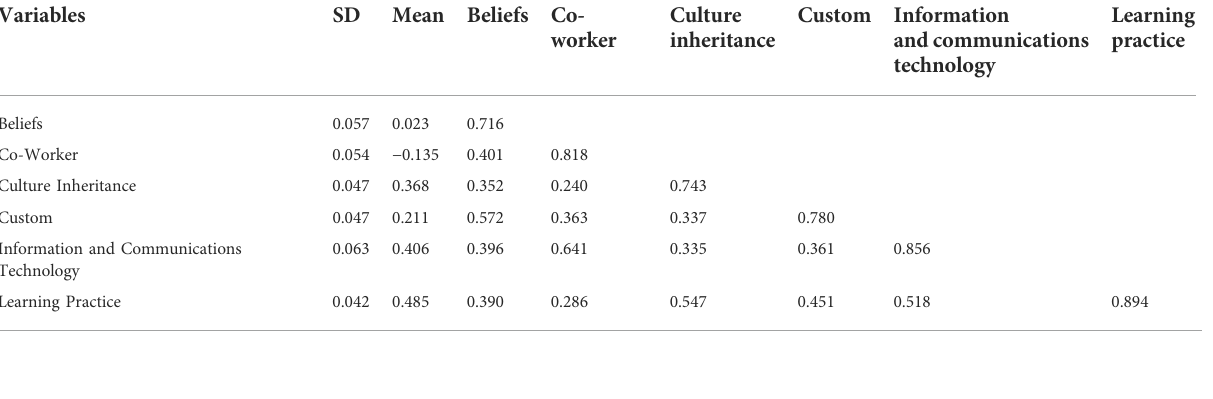
TABLE 4 HTMT ratio.